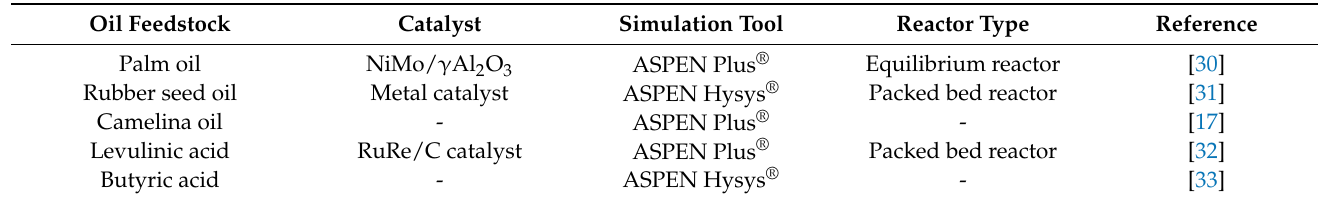
Table 2. Published literature on catalytic decarboxylation of simulation of